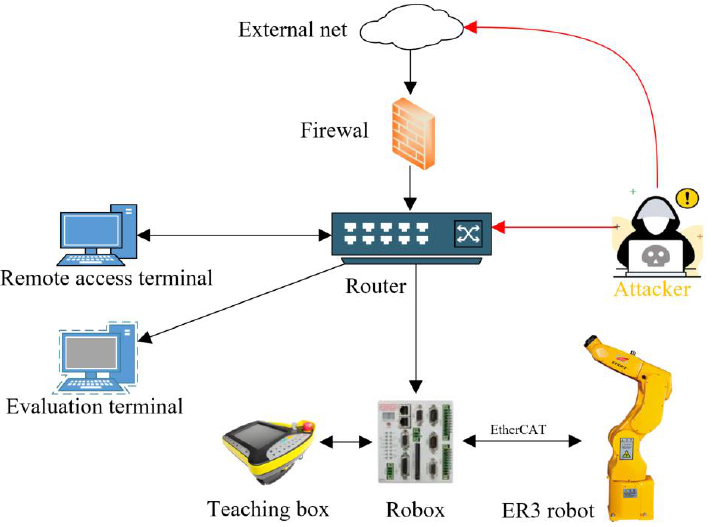
Figure 8. The topography of the